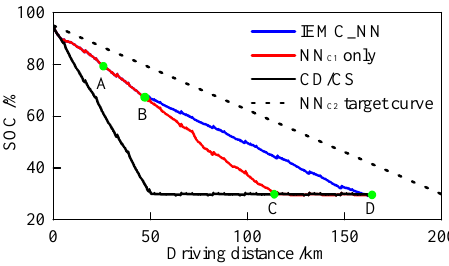
Figure 16. Battery SOC comparison when the target driving distance changes during the trip (HWFET